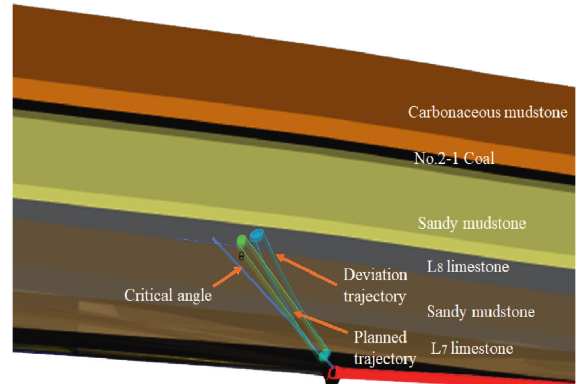
Figure 9: Comparison of stratigraphic